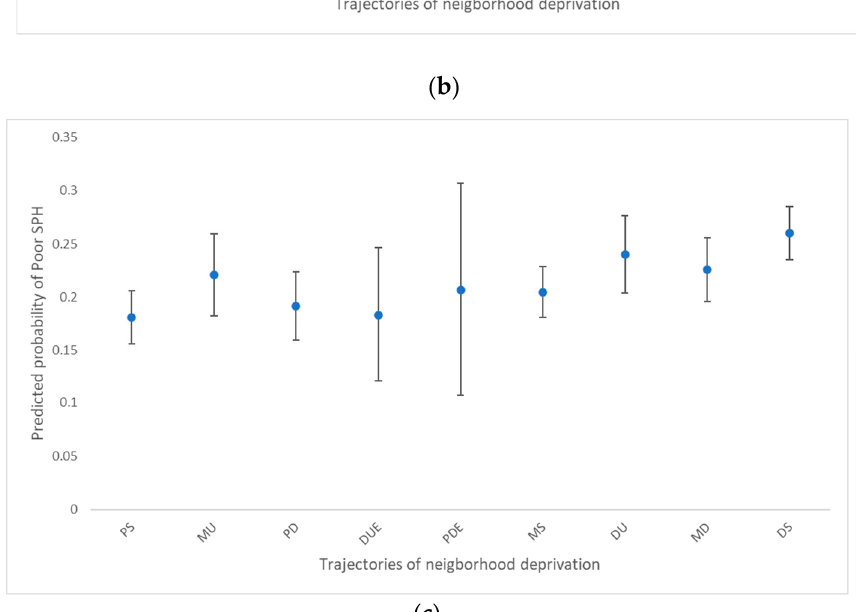
4.1. Key Results Using a large cohort of the adult population, this study examined variations in the reporting of poor SPH across different types of NDTs and determined whether these var- iations change according to age groups. These findings extend previous research on neighbourhoods’ effects on health by using long-term NDTs instead of only one time point. The study showed a detrimental association between long-term exposure to disad- vantaged neighbourhoods and poor SPH. Participants who were classified as having dis- advantaged trajectories (Deprived Stable, Medium Stable, Deprived Upward, Medium Downward, and Deprived Stable) and those who declined to disadvantaged trajectories (Privileged Downward and Privileged Downward Extreme) had higher odds of reporting poor SPH, even after controlling for confounders. Participants with sustained exposure to neighbourhood deprivation over their life course had higher odds of developing poor SPH. Similar to previous studies, cumulative exposure to greater neighbourhood deprivation was associated with poor SPH [17,21,39]. This finding is consistent with the life course theory, which suggests that accumulation of exposure to neighbourhood deprivation at different life stages may be harmful for SPH [4]. The results of this study support the existing evidence suggesting an association be- tween long-term NDTs and poor health outcomes [2,19,24,40–42]. Using NDTs, Letarte et al. found that women exposed to disadvantaged trajectories (Deprived Upward, Average Downward, or Deprived Trajectory) had higher odds of living with obesity than those exposed to the Privileged trajectory [24]. Additionally, studies using similar NDTs found that neighbourhood deprivation was associated with diabetes [7], psychological distress [19], weight gain [40,43] and intimate partner violence [41]. Using trajectories of exposure to high-poverty neighbourhoods, Yang and South found that neighbourhood poverty tra- jectories were a stronger predictor of self-rated health around age 40 [23]. According to a study by Johnson et al., living in poor neighbourhoods during young adulthood is strongly associated with negative health outcomes later in life [44]. Many plausible pathways explain which long-term NDTs might impact general health status. Previous studies suggested that inhabitants living for long periods in de- prived neighbourhoods might be more exposed to environmental injustice, such as high